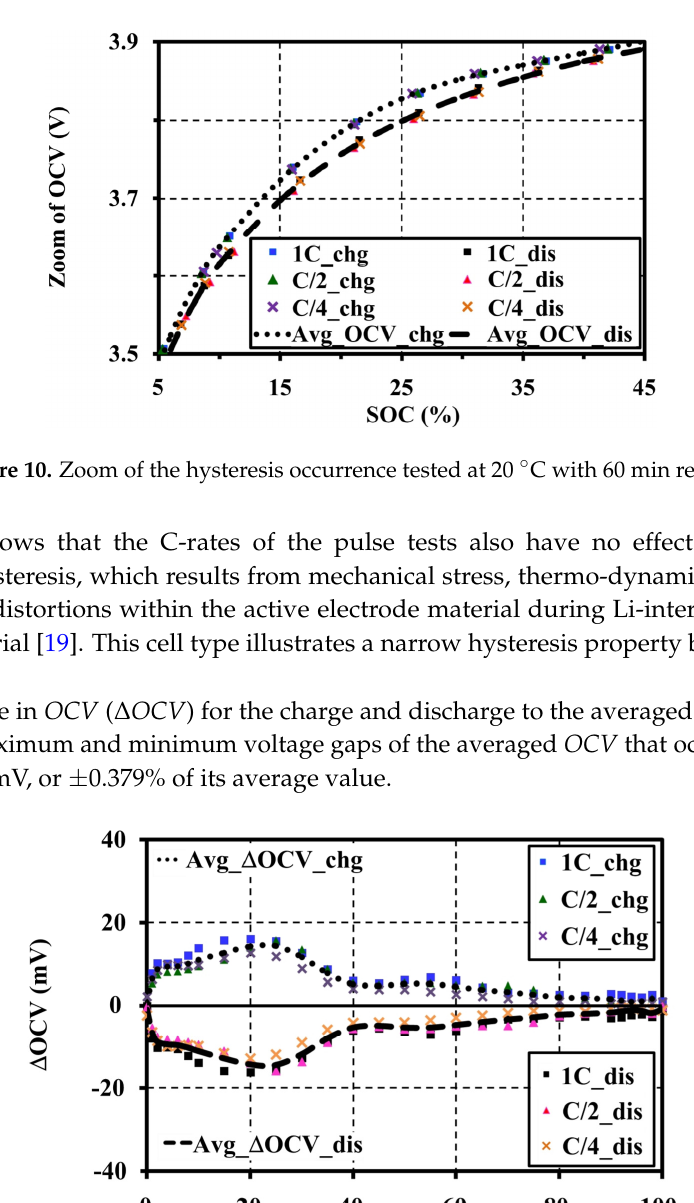
Figure 11. Δ OCV for the averaged charge and discharge values tested at 20 °C with 60 min resting. Figure 11. ∆ OCV for the averaged charge and discharge values tested at 20 ◦ C with 60 min